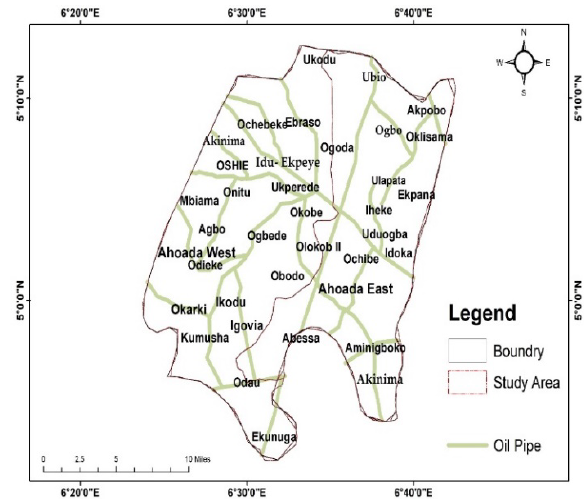
Figure 2. Map of the study area and the oil pipelines criss crossing the communities